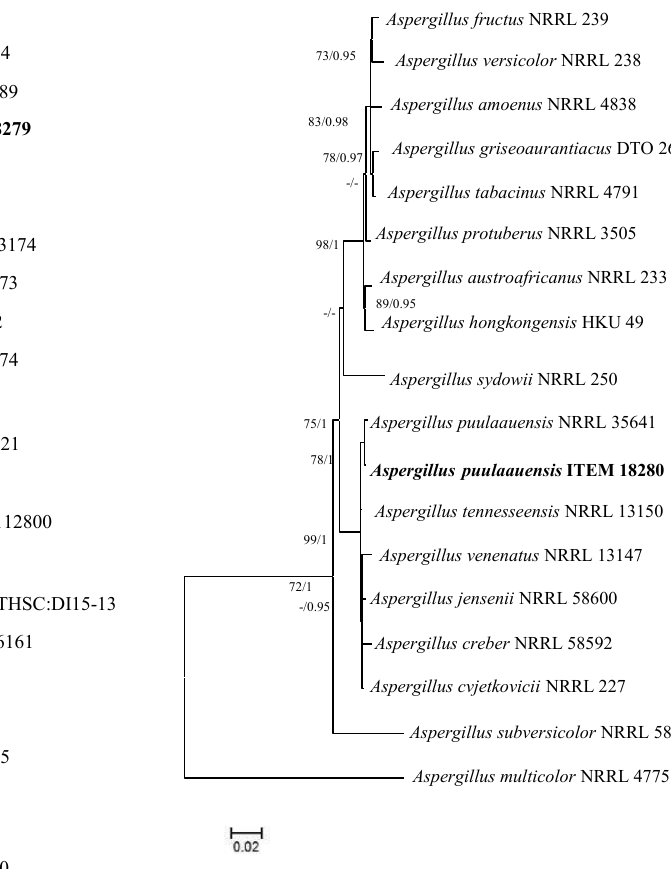
Figure 2. Phylogenetic tree of combined benA , CaM and ITS sequences of Aspergillus spp. (a) Maximum Likelihood tree of Aspergillus pallidofulvus ITEM 18279 (ASls13) and representative taxa of Aspergillus section Circumdati . Aspergillus robustus NRRL 6362 and A. tanneri NRRL 62425 are outgroups. (b) Maximum Likelihood tree of A. puulaauensis ITEM 18280 (AS100) and repre- sentative taxa of Aspergillus species belonging to A. versicolor clade. Aspergillus subversicolores NRRL 58999 and A. multicolor NRRL 4775 are outgroups. The BI posterior probabilities values and boot- strap percentages of the ML analysis are indicated above the nodes (BS/pp). Values less than 70% bootstrap support in the ML analysis and less than 0.95 posterior probability in the Bayesian analysis are indicated with a hyphen. Branches with high support are